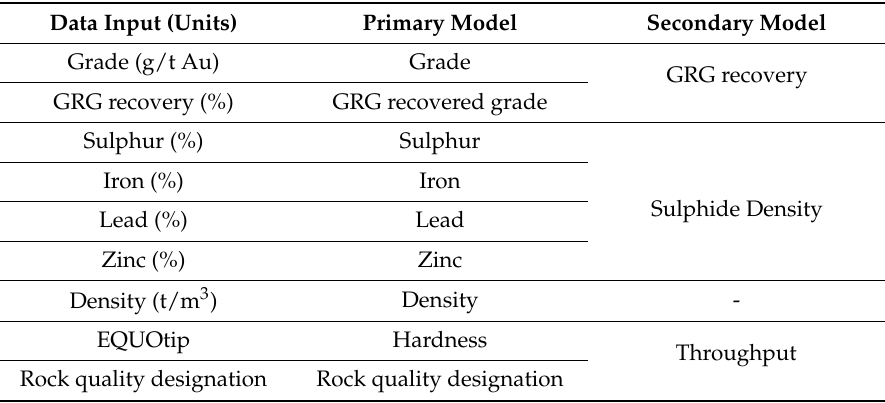
Table 25. Geometallurgical programme block model inputs and